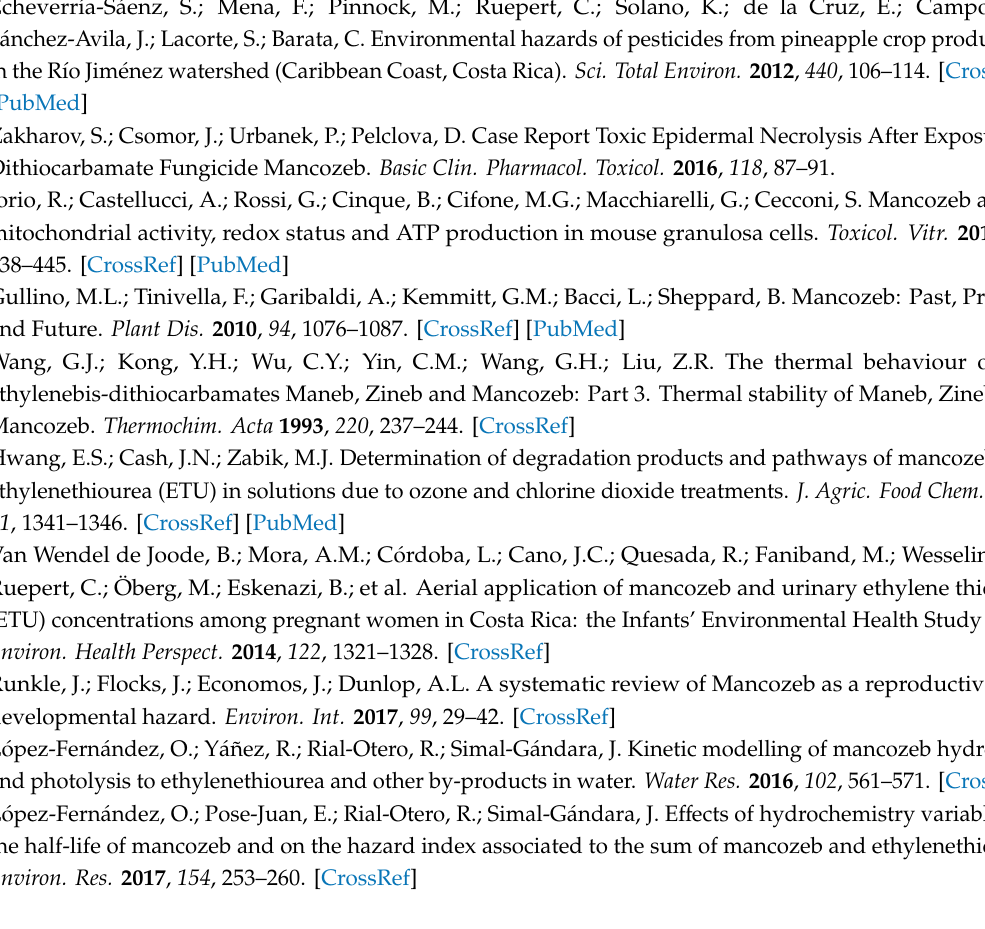
Figure S1: UV–vis absorption spectrum of gold nanoparticles, Figure S2: Cyclic voltammetry curves of aqueous solutions of MCZ, Figure S3: UV–vis spectra of mancozeb at 25 ◦ C, Figure S4: Increment and linear decrease absorbance vs temperature, Figure S5: Plots of absorbance spectrums vs days at ambient